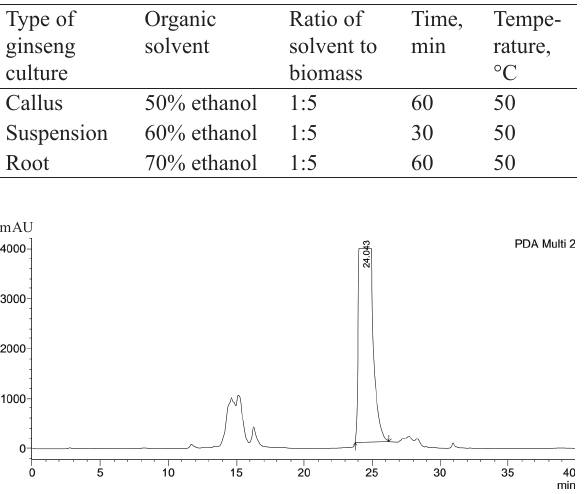
Table 7 Optimal parameters for extracting biologically active substances from the dried biomass of ginseng callus, suspension, and root cultures